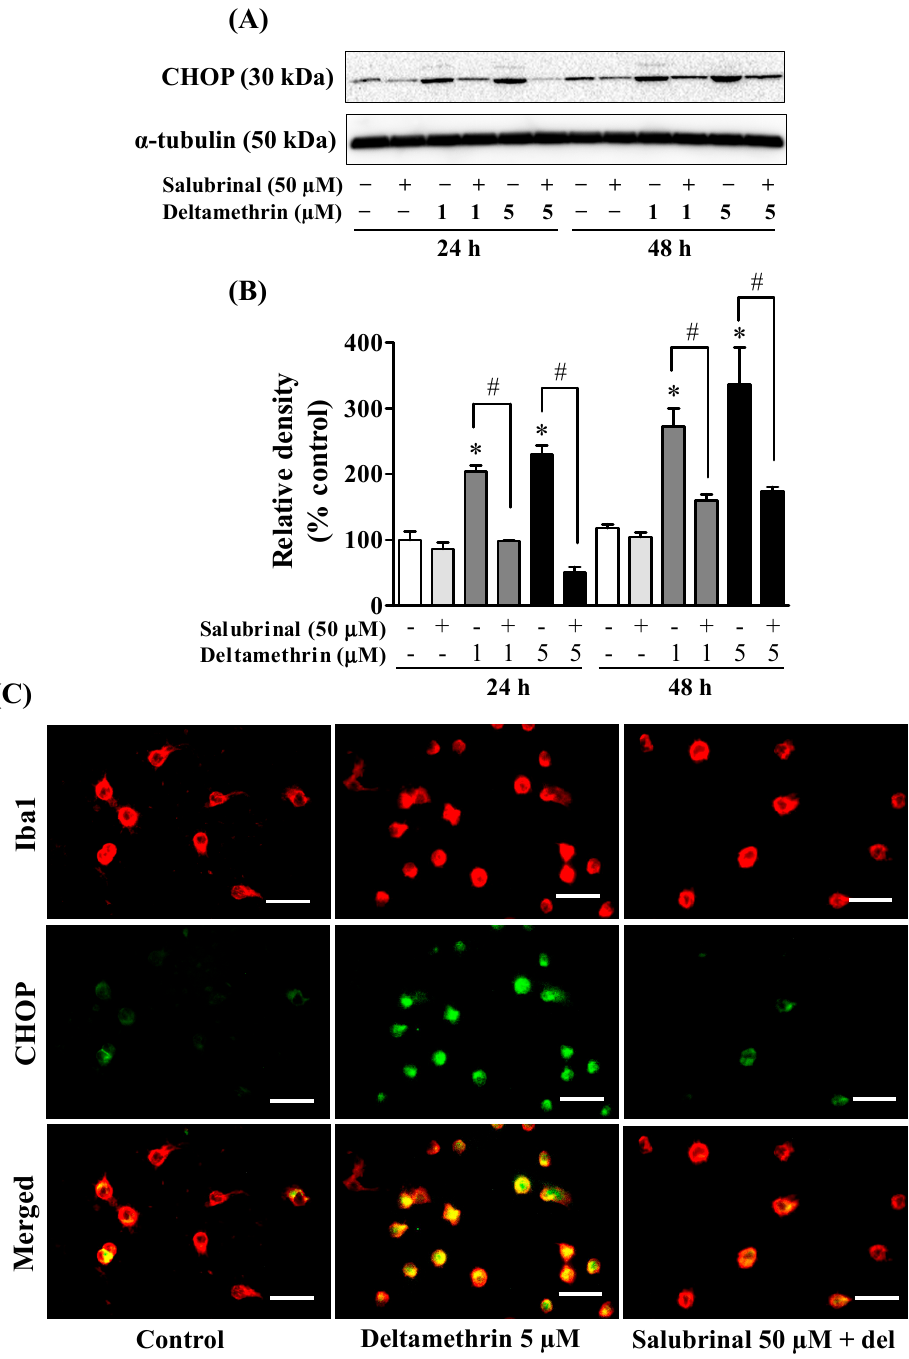
Figure 6. Salubrinal prevents deltamethrin-induced activation of stress pathways in MMCs cells. Protein levels of CHOP in MMCs were quantified by densitometry from Western blots ( A ). The results are reported as relative band densities in bar graphs ( B ). The values represent mean ± SEM from three independent experiments, each of which was performed in triplicate. An asterisk denotes significant difference from the control group, and a hashtag denotes significant differences between deltamethrin and deltamethrin + salubrinal ( p < 0.05). Expression of CHOP in MMCs ( C ). MMCs were labeled with anti-Iba1 antibody (red) and CHOP protein was visualized by immunolabeling (green). Co-localization of CHOP and Iba1 is shown in yellow. Scale bar = 200 µ